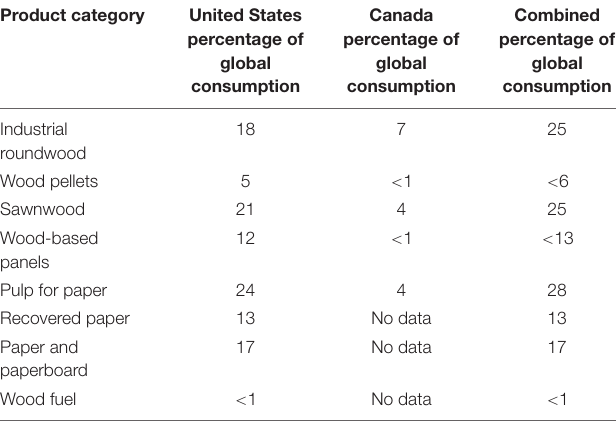
TABLE 2 | The United States and Canada share of global forest products consumption in